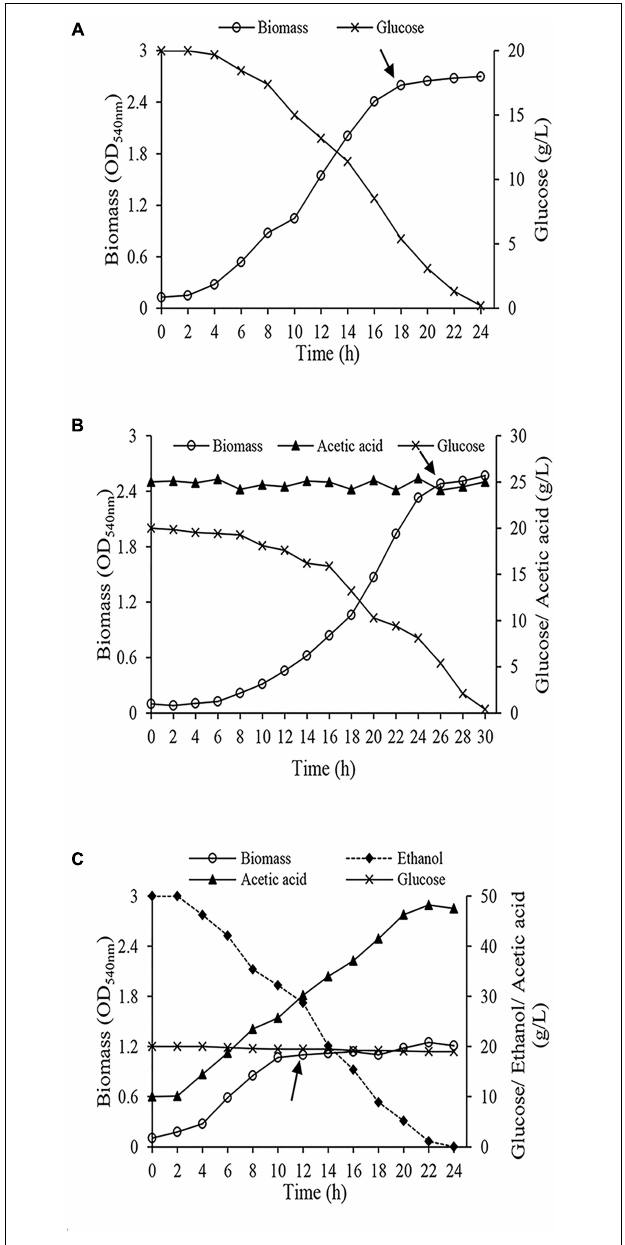
FIGURE 2 | Growth of Acetobacter senegalensis LMG 23690 T in different carbon sources under regulated conditions (Lab-scale bioreactor, at 30 ◦ C and pH 3.9 ± 0.1) (A) cells acclimated to glucose (Glc condition), (B) cells acclimated to a mixture of ethanol and glucose (EtOH condition), (C)